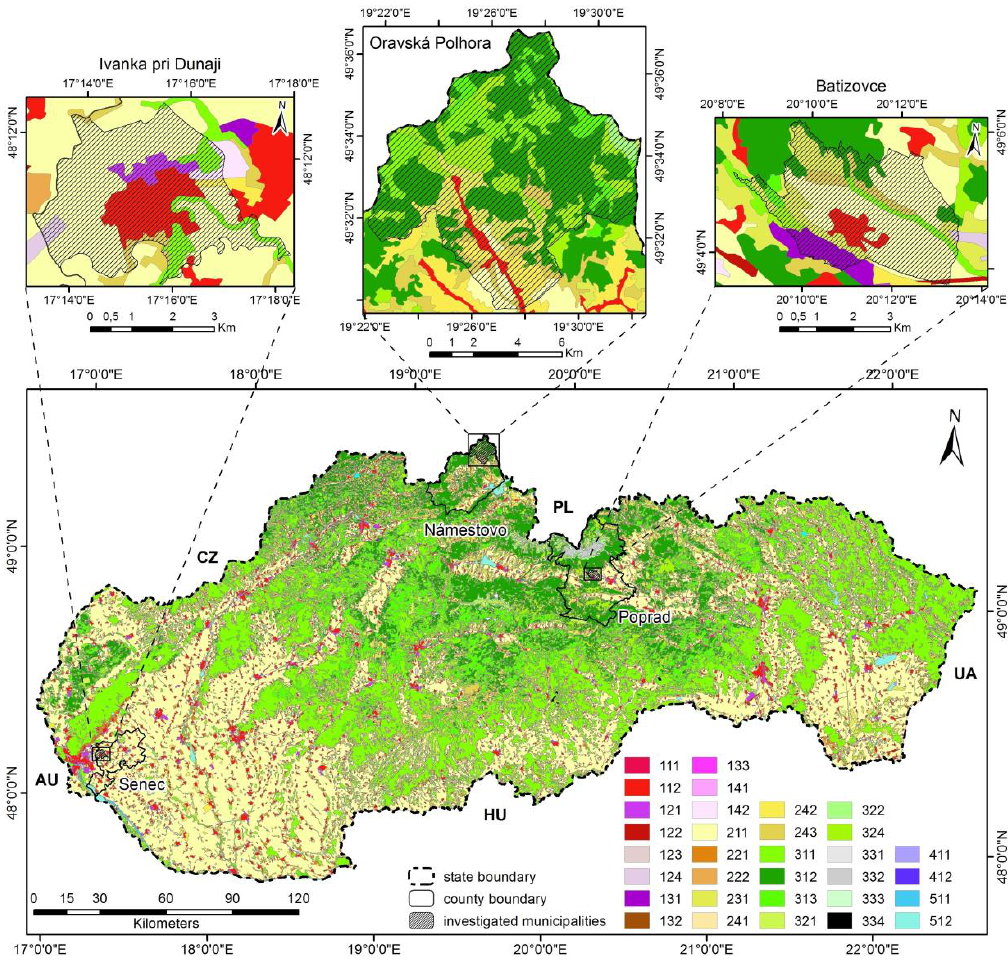
Figure 1. Localization of investigated counties and municipalities with the CORINE Land Cover (CLC3) inventory in the Slovak Republic in 2018. Legend of land cover classes is available at the following link: https: // land.copernicus.eu / pan-european / corine-land-cover /